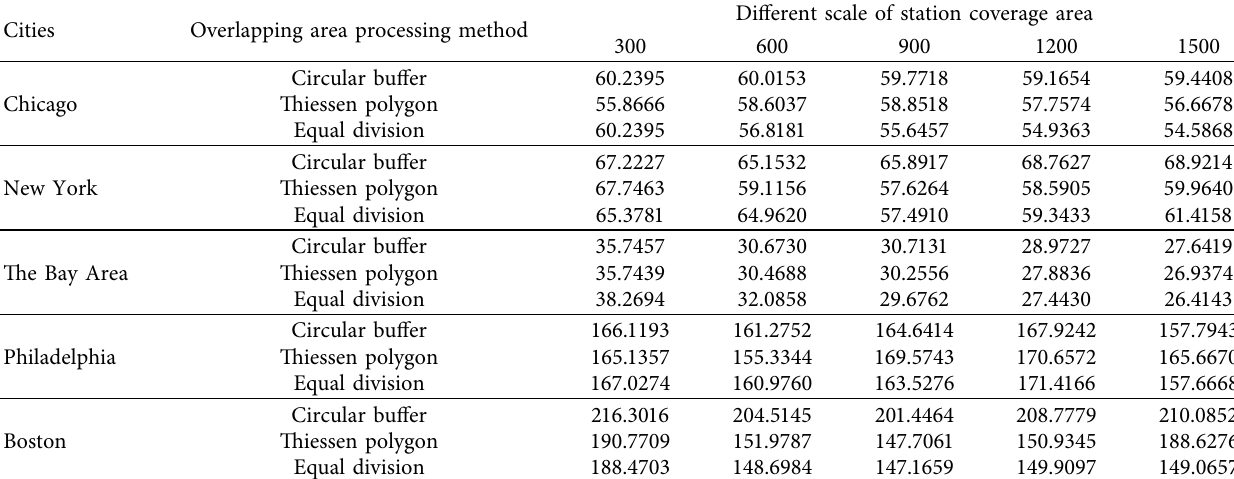
Table 10: Table of the MAPE of negative binomial regression model in five cities.